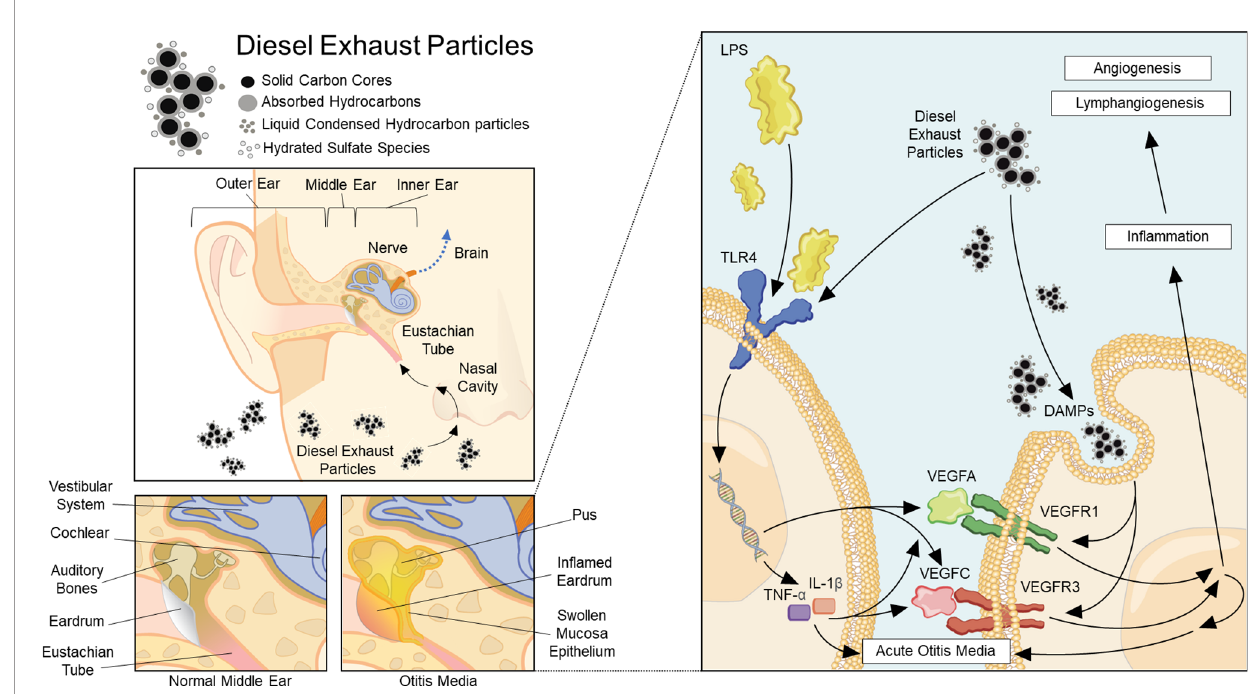
FIGURE 6 | Summary of the pathway of diesel exhaust particle-induced angiogenesis and lymphangiogenesis in acute otitis